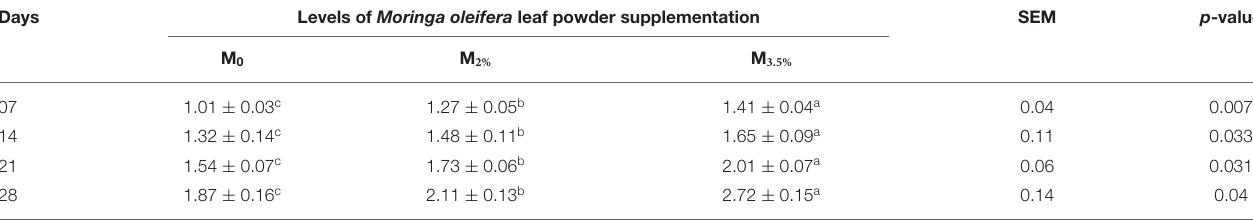
TABLE 10 | Effect of Moringa oleifera leaf powder supplementation on milk production (liters) in Beetal goats. Days Levels of Moringa oleifera leaf powder supplementation SEM p -value